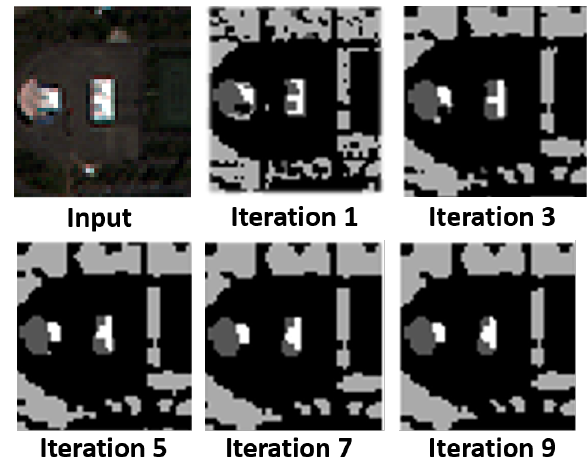
Figure 2. Evolution of labelling during optimization. Table 1. Average performance of the algorithms.